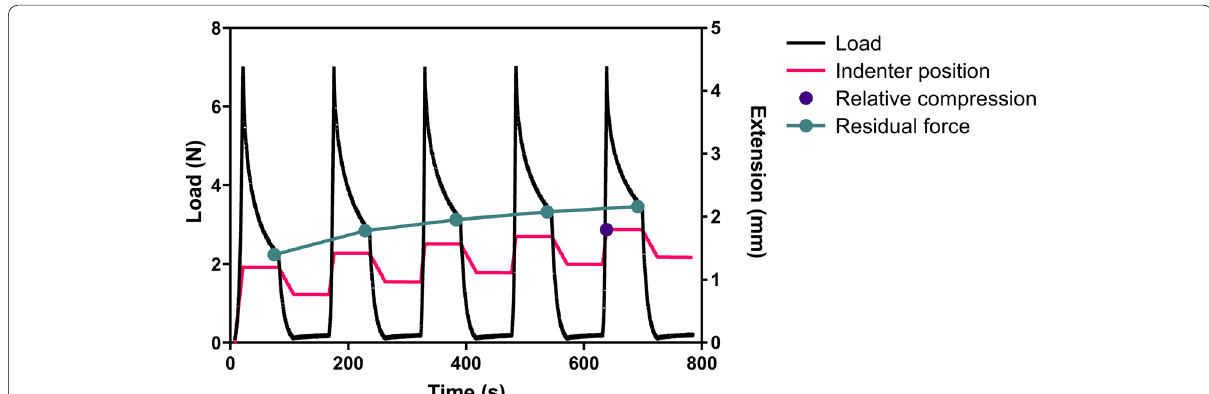
Fig. 1 Graphical overview showing a typical load curve of the mechanical test consisting of five test cycles. The graphical course of preload, compression, relaxation, and unloading is shown in black. Relative compression (purple dot) was calculated from the indenter position at the end of dynamic compression of the 5th test cycle. The residual force was defined as the recorded load at the end of static compression of each test cycle. Load and residual force are shown on the left y-axis and indenter position and relative compression on the right